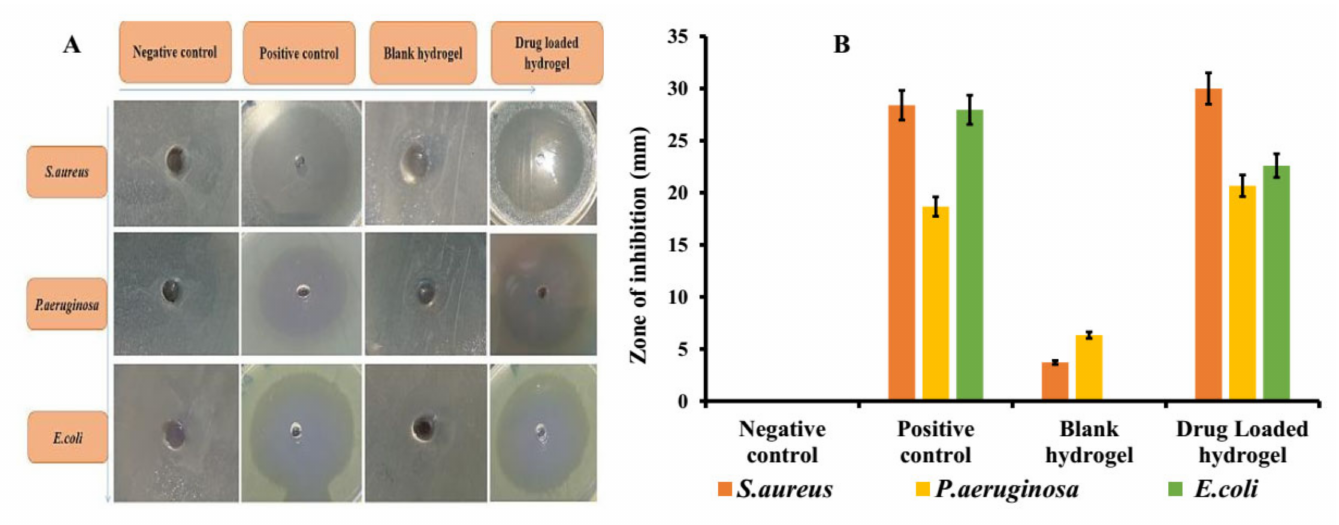
Figure 5. ( A ) Zone of inhibition against S. aureus , P. aregnosa and E. coli in positive control, neg- ative control, blank hydrogel, and drug-loaded hydrogel; ( B ) graphical representation of zone of inhibition